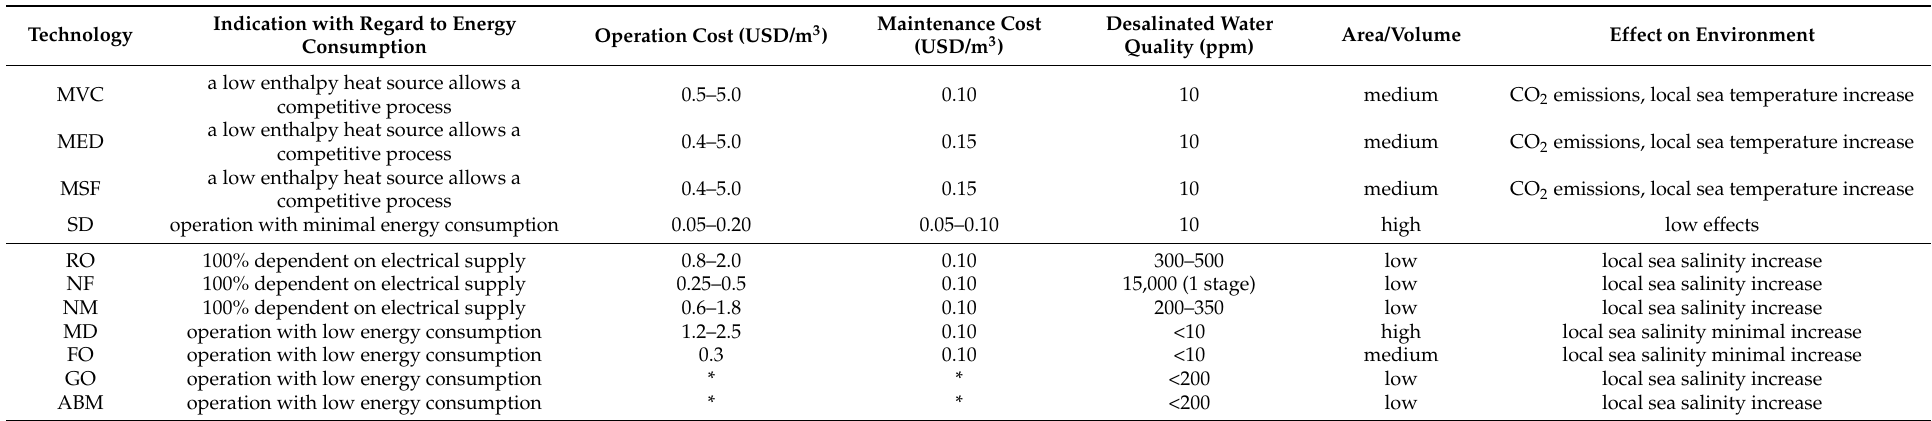
Table 5. Summary of desalination technology characteristics (part 2).